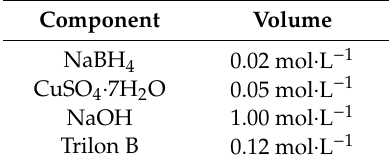
Table 1. Composition of the mixture applied for catalyst deposition (Cu–B alloy).